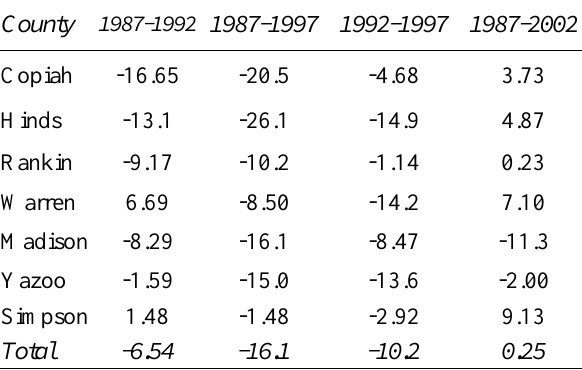
Table 1c : Percentage of Change in Farm Acreage 1987